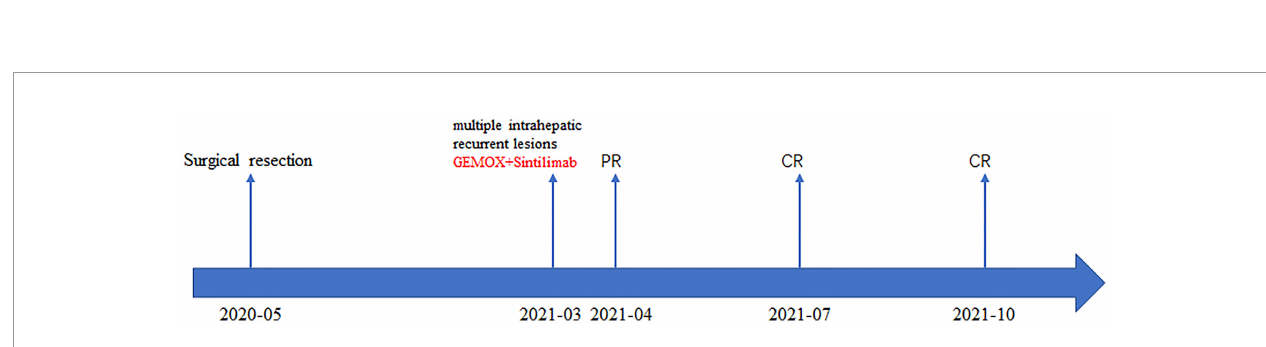
FIGURE 3 | The patient ’ s timeline of surgery, treatment, and tumor response. PR, partial response; CR, complete